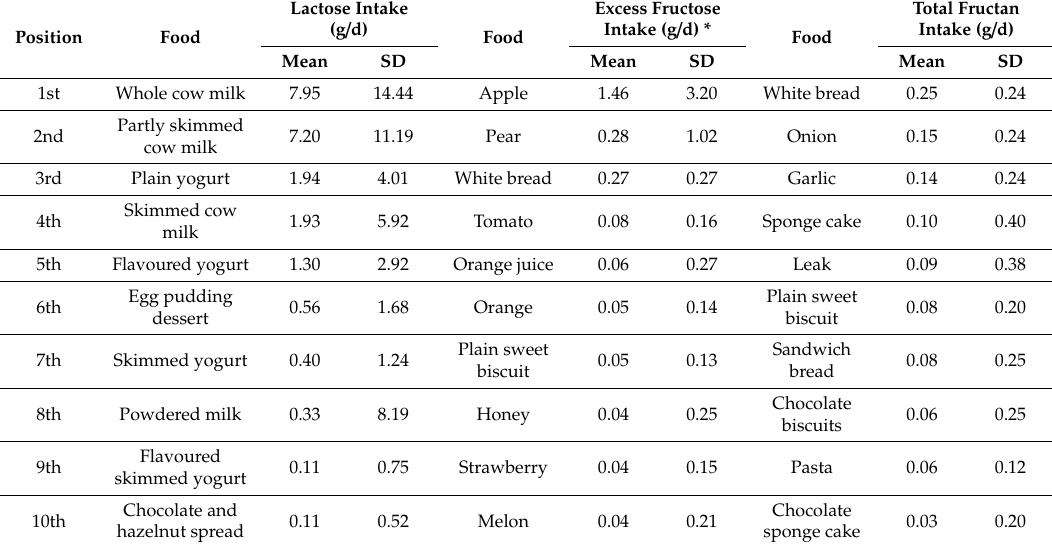
Table 3. Top ten foods representing the higher intake source of lactose, excess fructose and total fructan in Spanish diet of adolescent population aged between 10 and 17 years